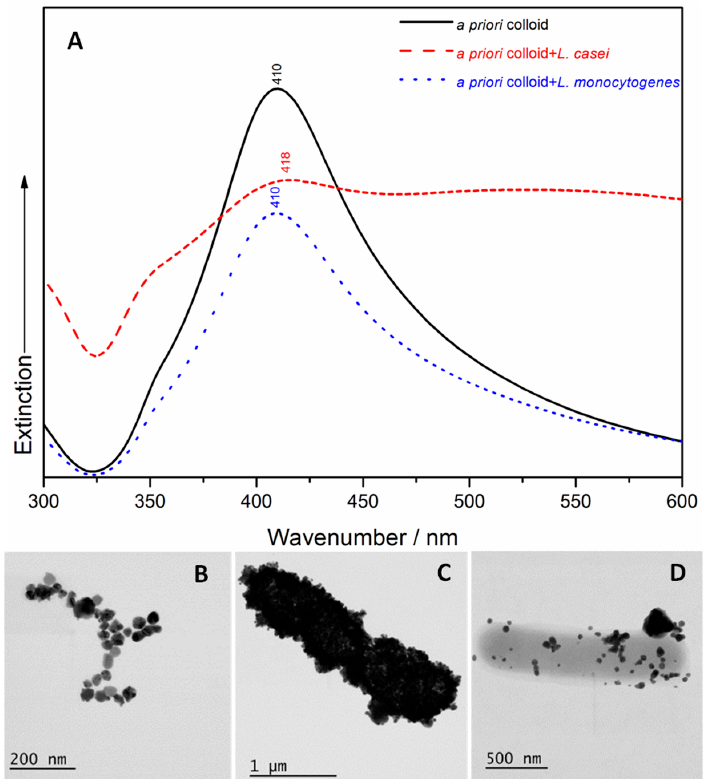
Figure 1. ( A ) The UV/Vis spectra of the a priori colloid, the Lactobacillus casei surface-enhanced Raman scattering (SERS) sample and the Listeria monocytogenes SERS sample. Scanning Transmission Electron Microscopy (STEM) images of the a priori colloid ( B ); the a priori synthesized Ag colloid coverage of the Lactobacillus casei ( C ) and Listeria monocytogenes ( D ) cell membranes.